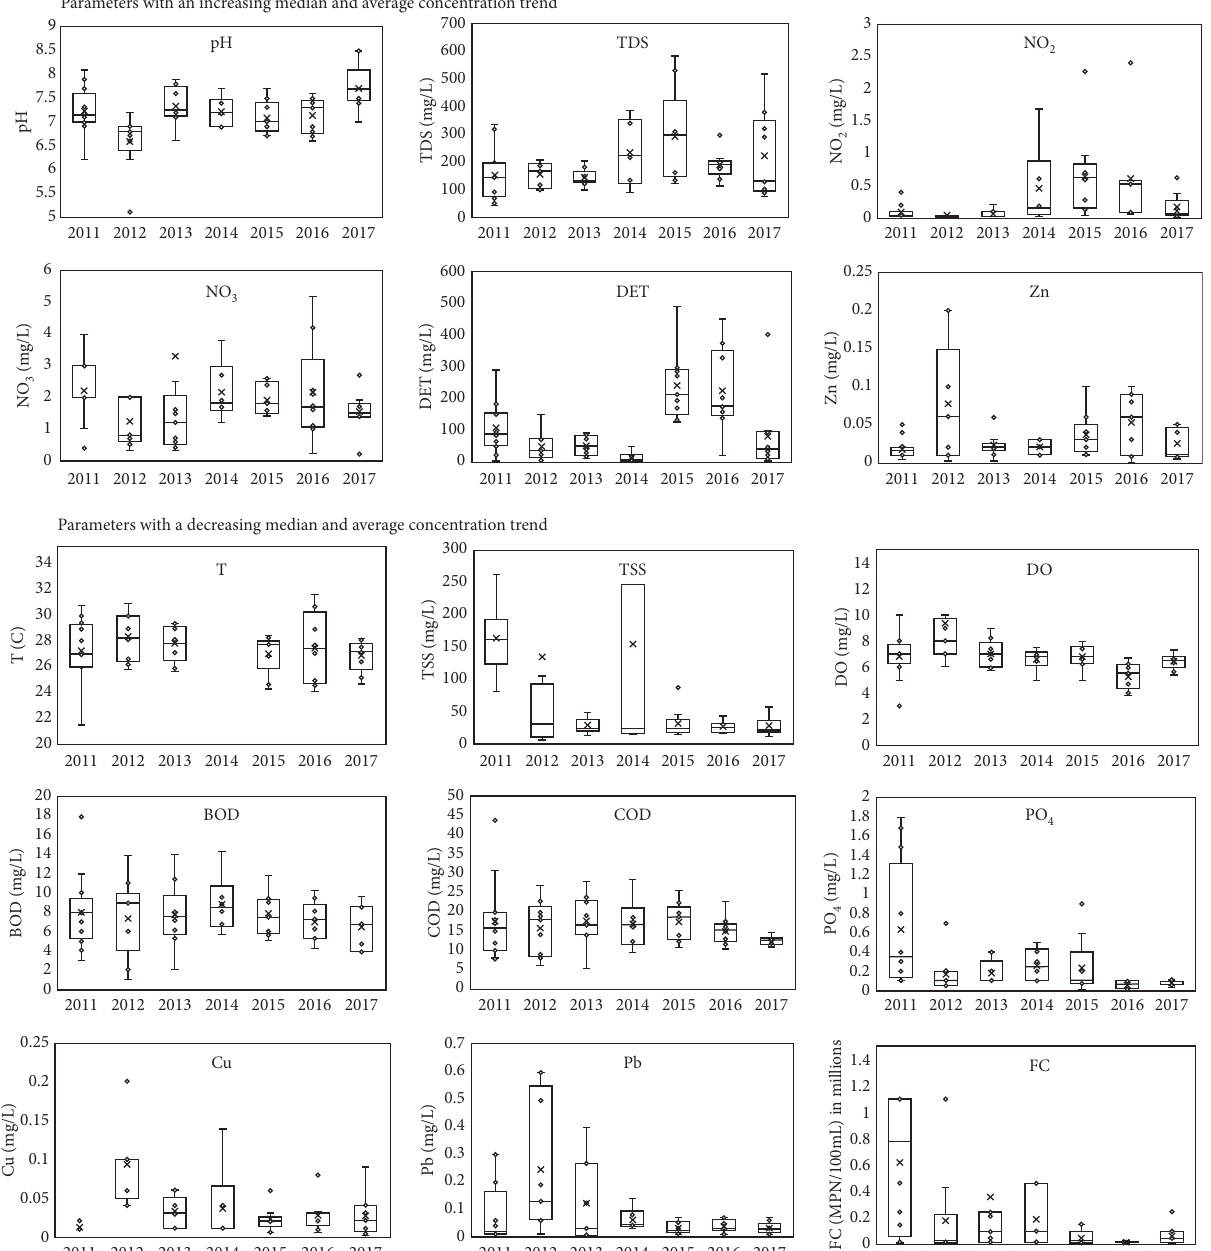
Figure 3: Temporal trend of the water quality in Code